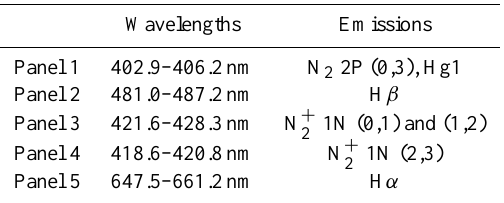
Table 1. The spectral properties of the five panels of the interference filter mosaic.